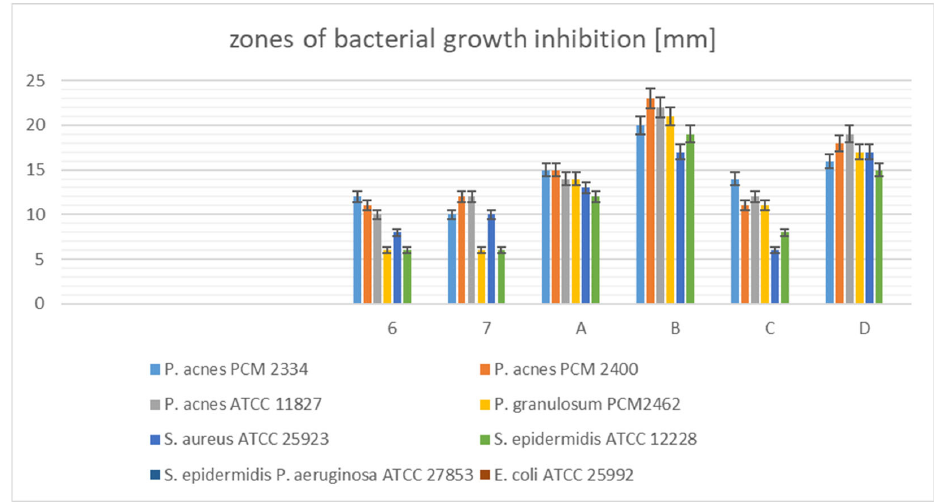
Figure 7 . Zones of bacterial growth inhibition of the Cotoneaster extracts. Figure 7. Zones of bacterial growth inhibition of the Cotoneaster